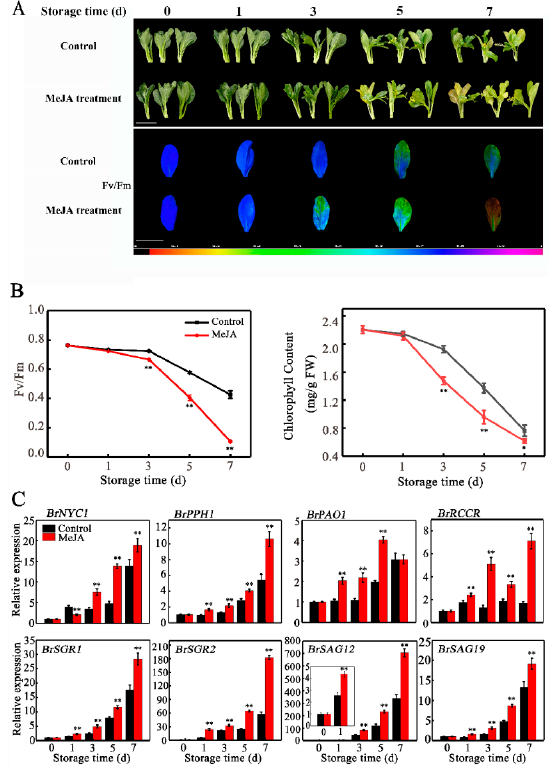
Figure 1. Methyl jasmonate (MeJA) treatment promotes leaf senescence of Chinese flowering cabbage. ( A ) Appearance and chlorophyll fluorescence imaging (Fv/Fm) of control and MeJA-treated cabbage leaves during senescence. The false color code depicted at the bottom of the image ranges from 0 (black) to 1.0 (purple). Bar = 10 cm. ( B ) Changes in Fv/Fm and total chlorophyll content in control and MeJA-treated cabbage leaves during senescence. ( C ) Relative expression of six CCGs ( BrNYC1 , BrPPH1 , BrPAO1 , BrRCCR , BrSGR1 and BrSGR2 ) and two senescence-marker genes ( BrSAG12 and BrSAG19 ) in control and MeJA-treated cabbage leaves during senescence. Data presented in ( B ) and ( C ) are the mean ± SD of three biological replicates. Asterisks indicate a significant difference in MeJA-treated leaves compared with control leaves (Student’s t -test: * p < 0.05 and ** p <